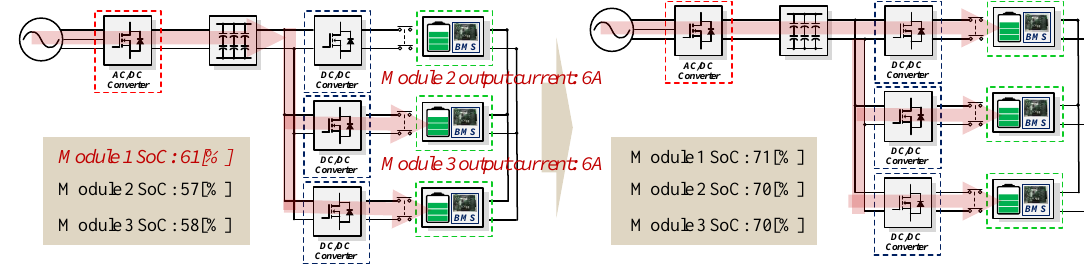
Figure 18. Charging time profile according to battery state.